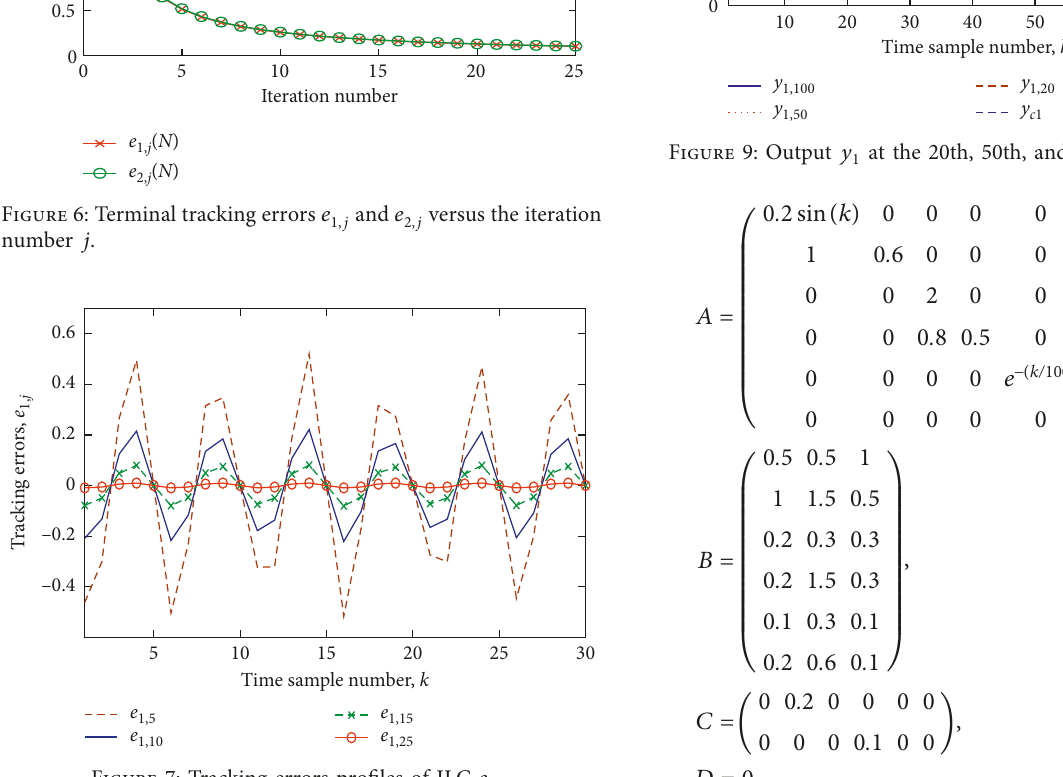
Figure 7: Tracking errors profiles of ILC e